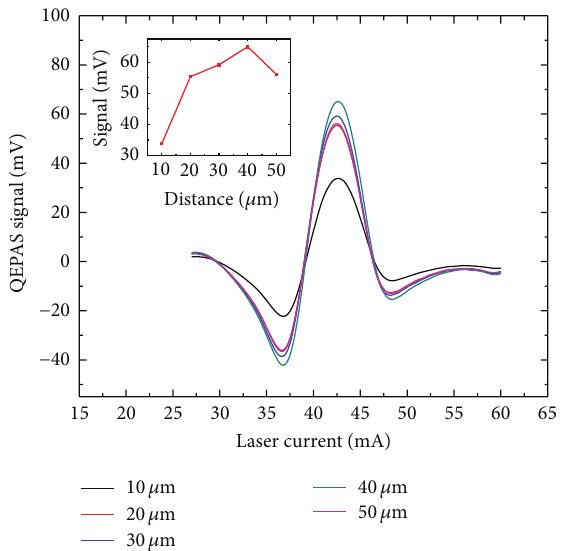
Figure 9: Signal amplitudes of the multi-QTF based “on-beam” spectrophone (Figure 4(d)) as a function of distance between QTF #4 and AmR